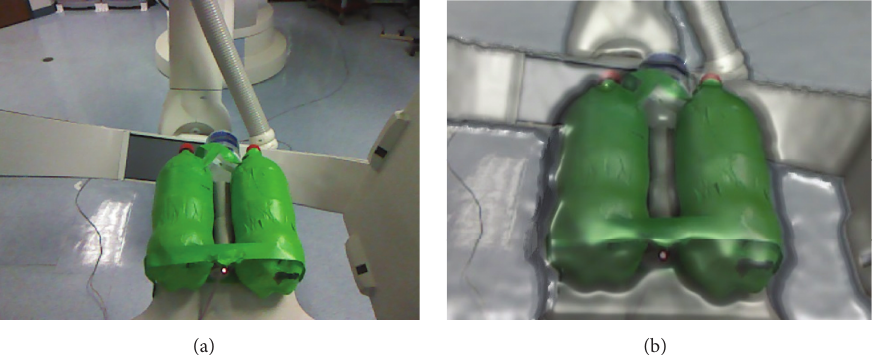
Figure 6: (a) shows an RGB image of the knee phantoms acquired by the Kinect camera. The corresponding preprocessed RGBD image can be seen in (b).